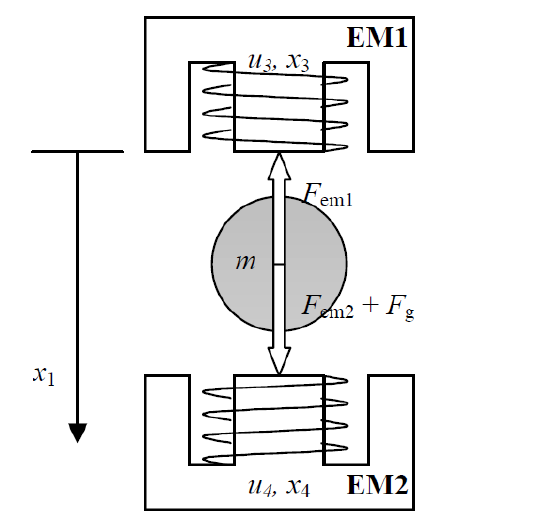
Figure 1. Examined magnetic levitation system